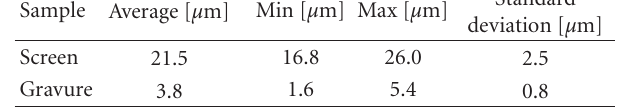
Figure 3: Location of the cross-section for the thickness measure- ment.